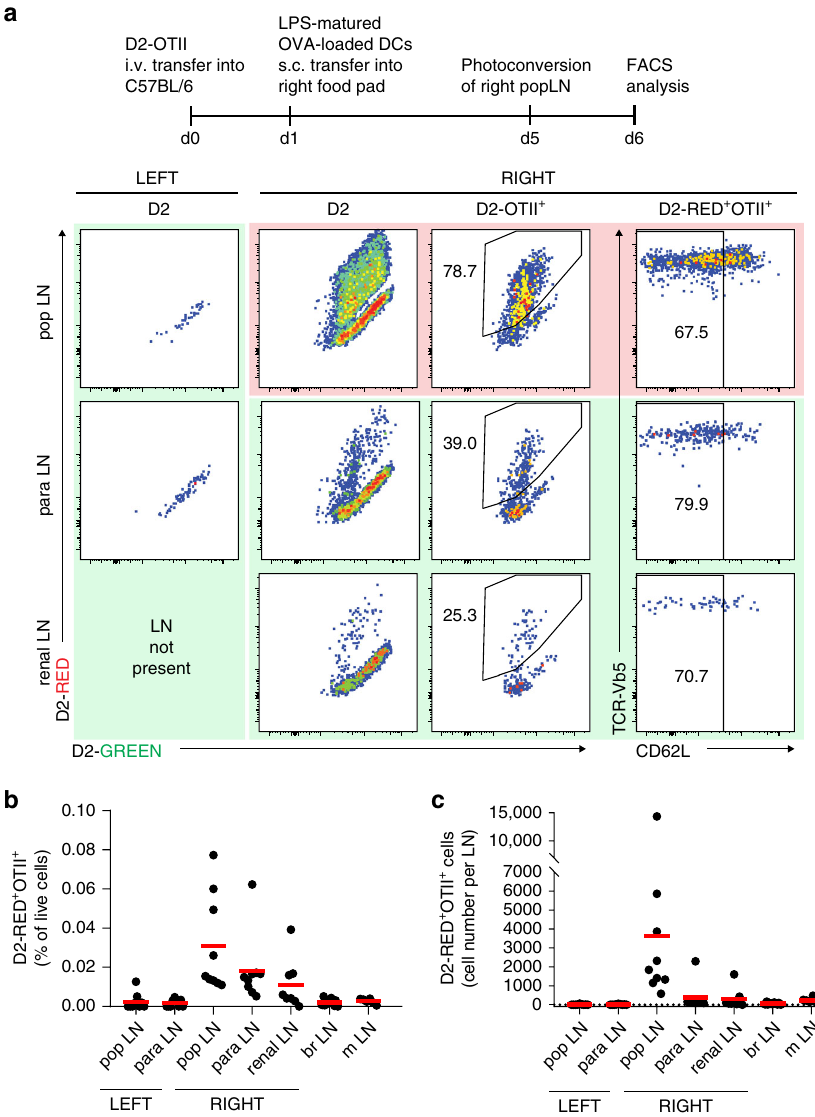
Fig. 1 Recently activated CD4 cells home to downstream LNs in vivo. a Experimental setup to investigate lymphocyte migration through lymphatic vessels. Recipient B6 mice received OTII + cells expressing the green-to-red photo-convertible fl uorescent protein Dendra2 (D2) and were immunized with LPS-matured OVA-loaded DCs into the right foodpad. Five days later, the right pop LN was photo-converted by exposure to UV light (see also Supplementary Fig. 1). Representative FACS plots from the left non-photo-converted (green background) and right photo-converted (red background) pop LNs and from non-photo-converted (green background) downstream para-aortic and renal LNs analyzed 24 h after UV exposure. Plots are gated on D2, D2-OTII + , or D2-RED + OTII + cells as indicated. b Frequency of D2-RED + OTII + cells among all living cells and c absolute cell counts of D2-RED + OTII +